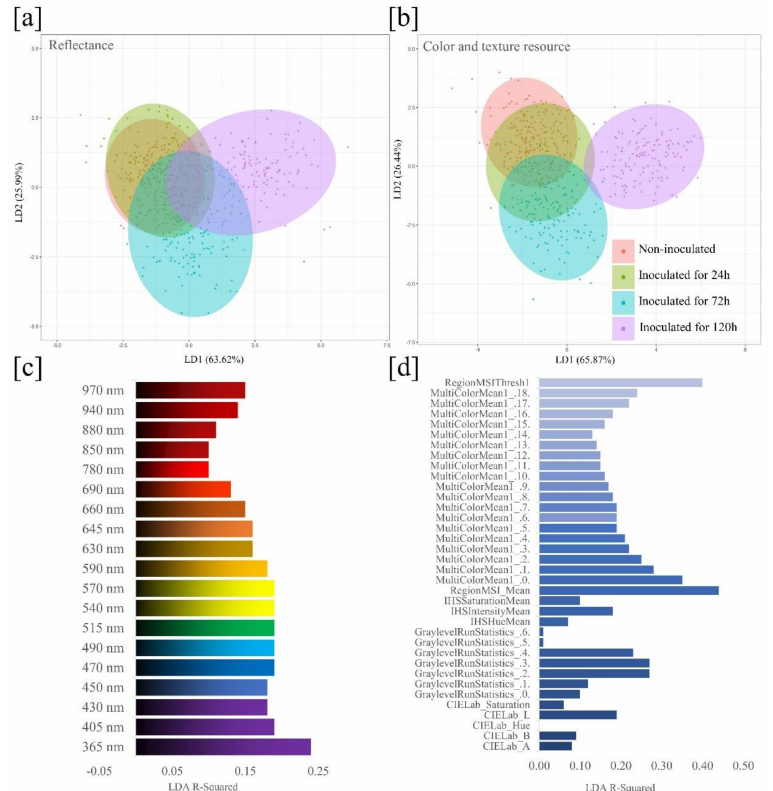
Figure 4. Linear discriminant analysis (LDA) score plot based on reflectance ( a ) and color and texture resources ( b ) of black oat seeds for classes of uninoculated and inoculated seeds with Drechslera avenae (Eidam) Sharif. ( a, b ) Ellipses show 95% confidence intervals for each seed health class. For each class, n = 200. ( c ) R-squared values indicate the spectral reflectance contributions of 19 wavelengths, and ( d ) the individual contribution of 36 variables extracted from multispectral images for classification of